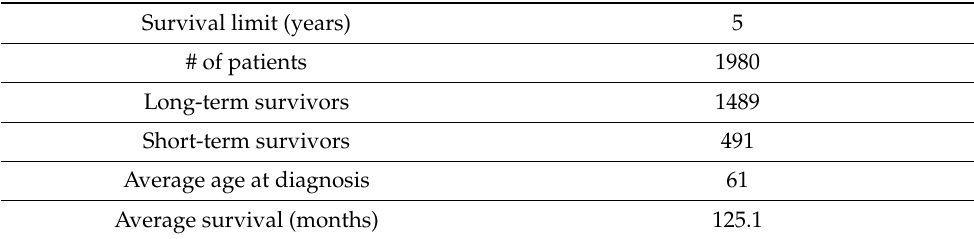
Table 6. Details about the